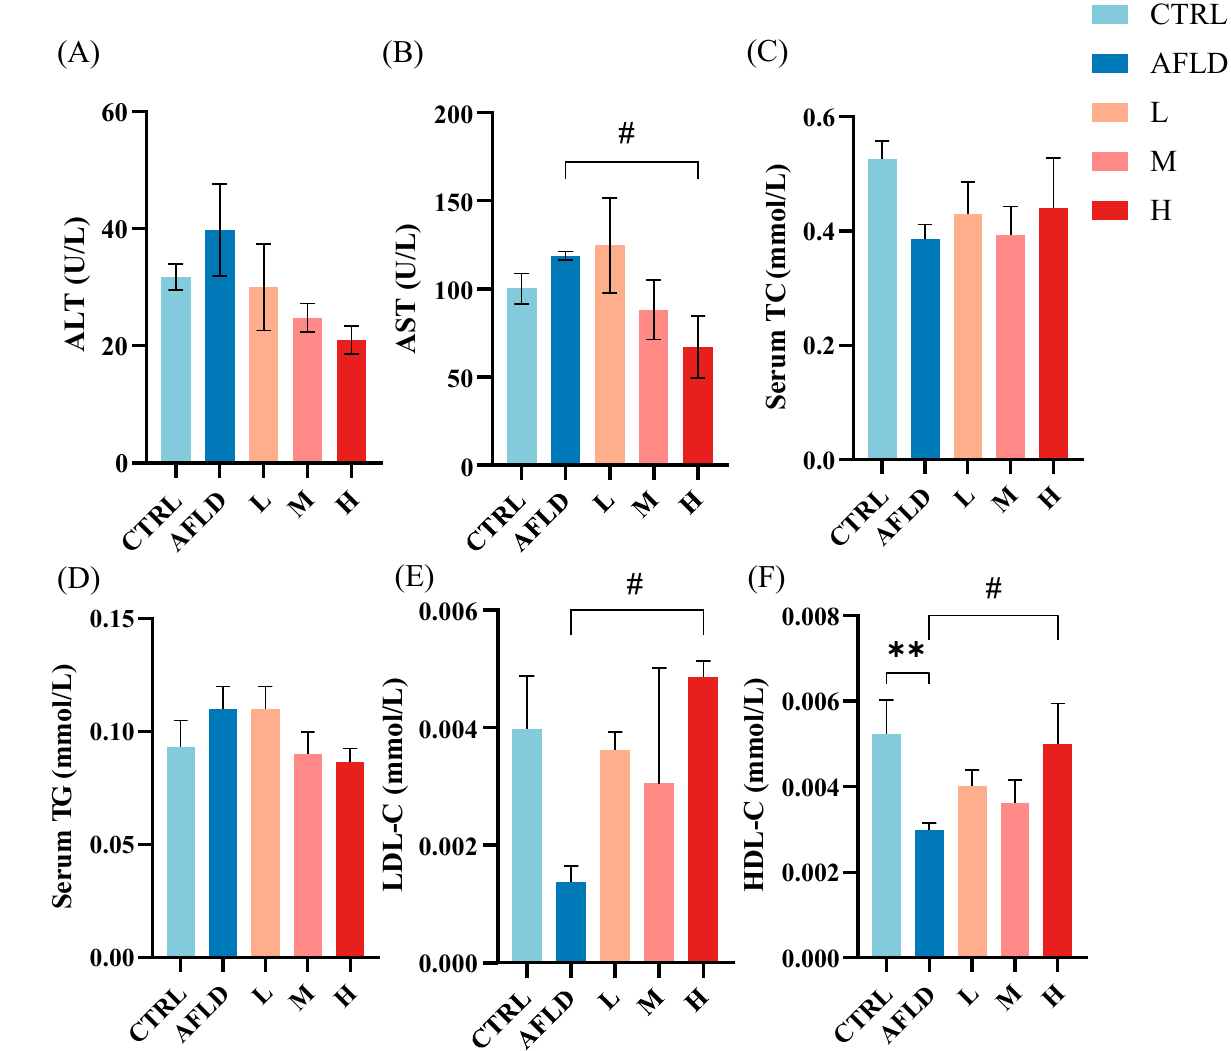
Figure 2. The effects of DOFE on serum biochemical markers in mice exposed to chronic alcohol consumption. ( A ) AST, aspartate transaminase; ( B ) ALT, alanine aminotransferase; ( C ) TC, total cholesterol; ( D ) TG, triacylglycerol; ( E ) HDL-C, high-density lipoprotein; ( F ) LDL-C, low-density lipoprotein. CTRL, the control group; AFLD, the model group; DOFE, Dendrobium officinale flower extract; L, the low concentration of DOFE; M, the medium concentration of DOFE ; H, the high concentration of DOFE. ** p < 0.01 for the CTRL groups compared with the AFLD groups; # p < 0.05 for the AFLD group compared with the DOFE high supplementary groups.